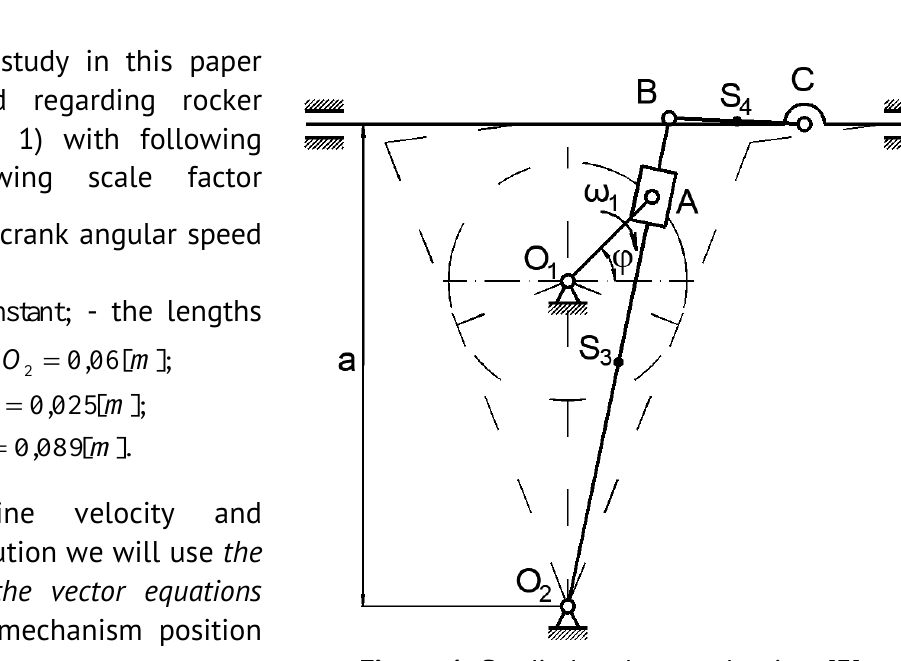
Figure 1. Studied rocker mechanism